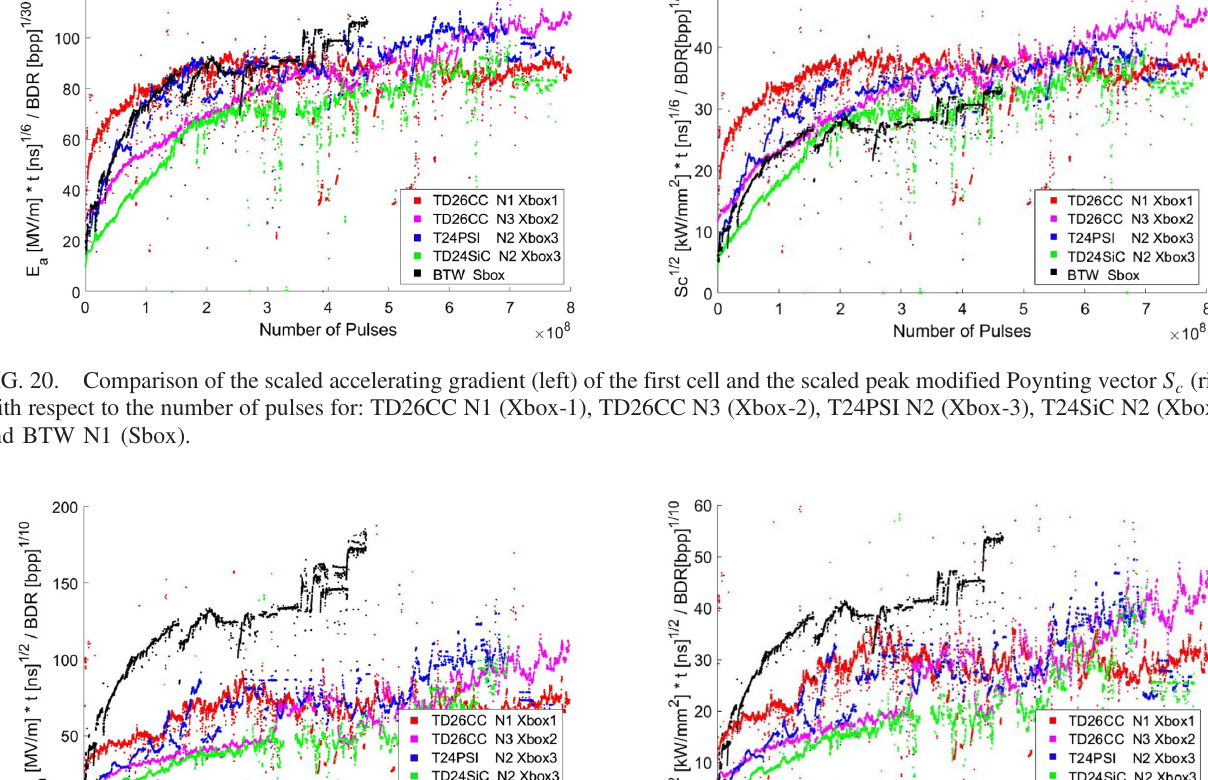
(Sbox).FIG. 19. Comparison of the peak surface electric field E the number of pulses for: TD26CC N1 (Xbox-1), TD26CC N3 (Xbox-2), T24PSI N2 (Xbox-3), T24SiC N2 (Xbox-3), and BTW N1 (Sbox).